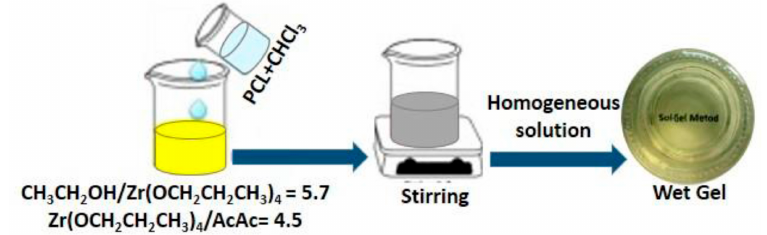
Figure 6. Flow chart of hybrids synthesis by the sol-gel method and the molar ratios between the reagents achieved in the sol.